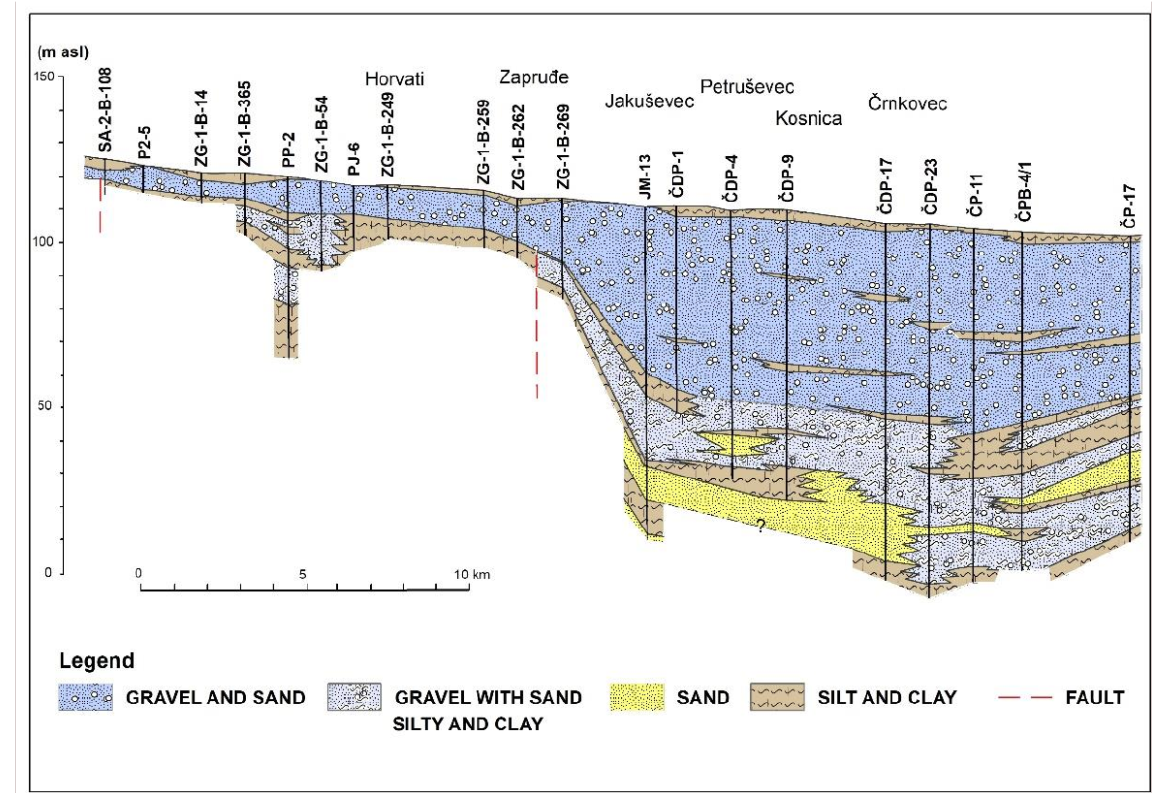
Figure 2. Hydrogeological cross section